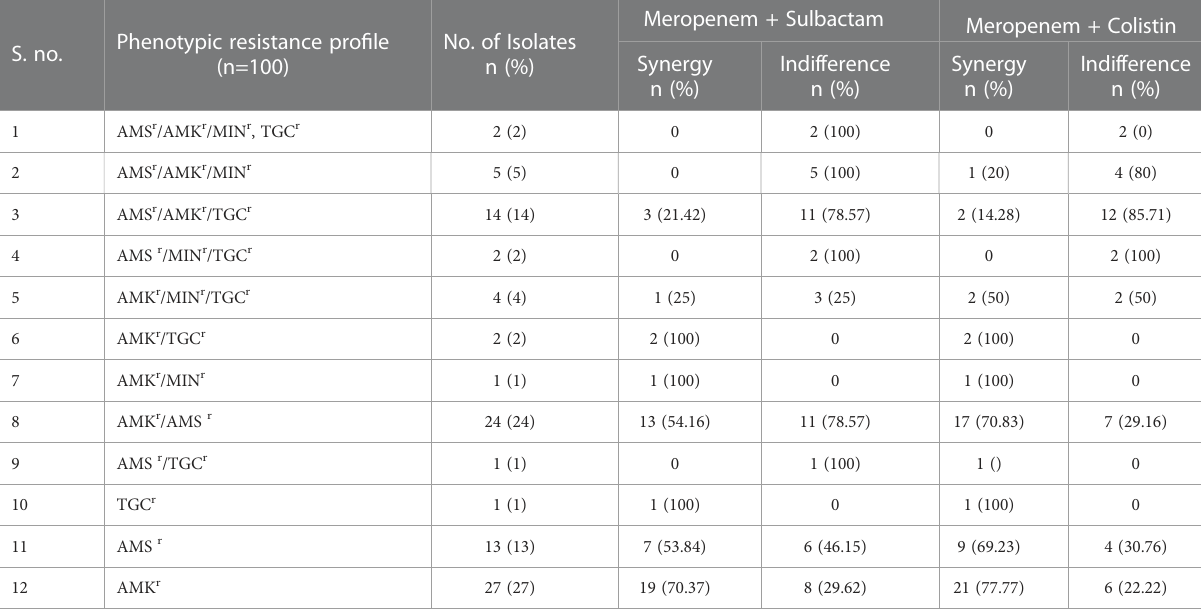
TABLE 6 Comparison of drug synergy and phenotypic non-carbapenem resistance pro fi le of 100 CRAB isolates.